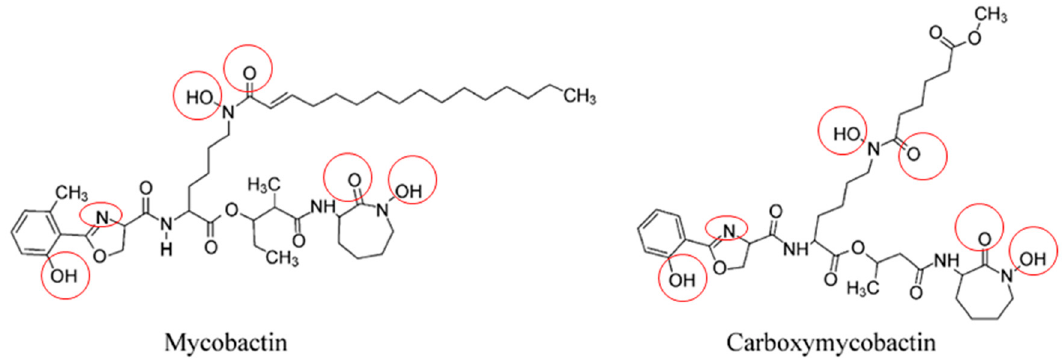
Figure 4. Structure of mycobactin and carboxymycobactin siderophores of pathogenic mycobacteria. This figure represents mycobactin and carboxymycobactin from M. tuberculosis with the iron-chelating residues circled in red.